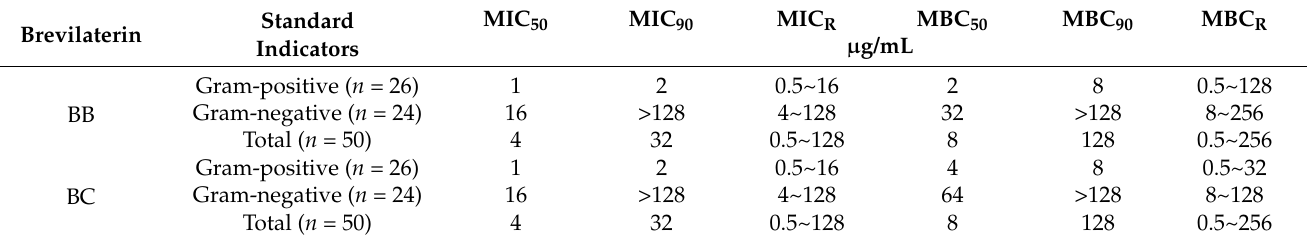
Table 3. Summary of MIC and MBC value of brevilaterin B and C against standard bacteria.